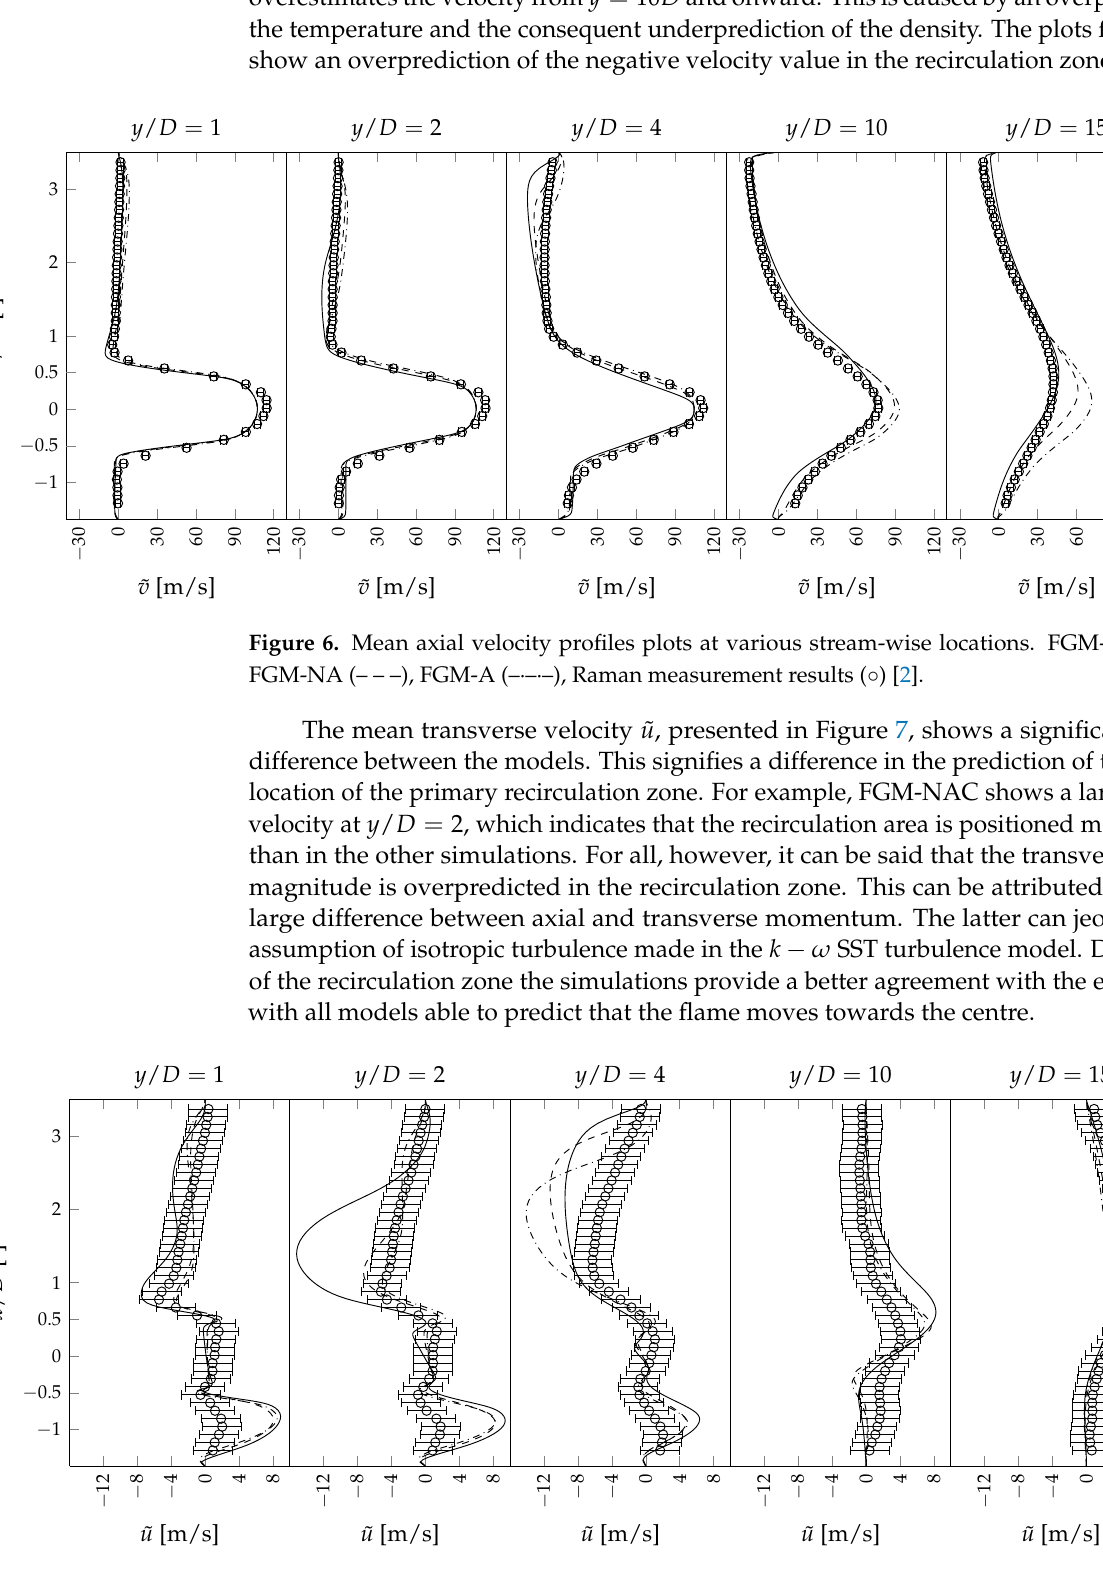
Figure 11. Mean transverse velocity profiles plots at various stream-wise locations. FGM-NAC ), FGM-A ( ), Raman measurement results ( )